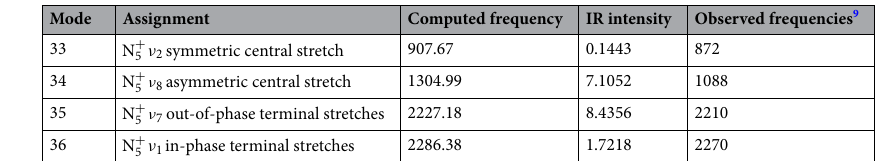
Table 2. Computational IR activity using the linear response approach at the PBEsol level of theory performed at Ŵ . Four N + 5 -related normal modes observed in the work of Christe et al. 9 are presented here for comparison. 1 2 Frequency wavenumbers are in cm − and IR intensities in (D/A)